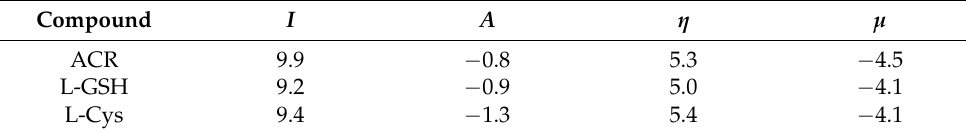
Table 2. Global DFT reactivity descriptors in